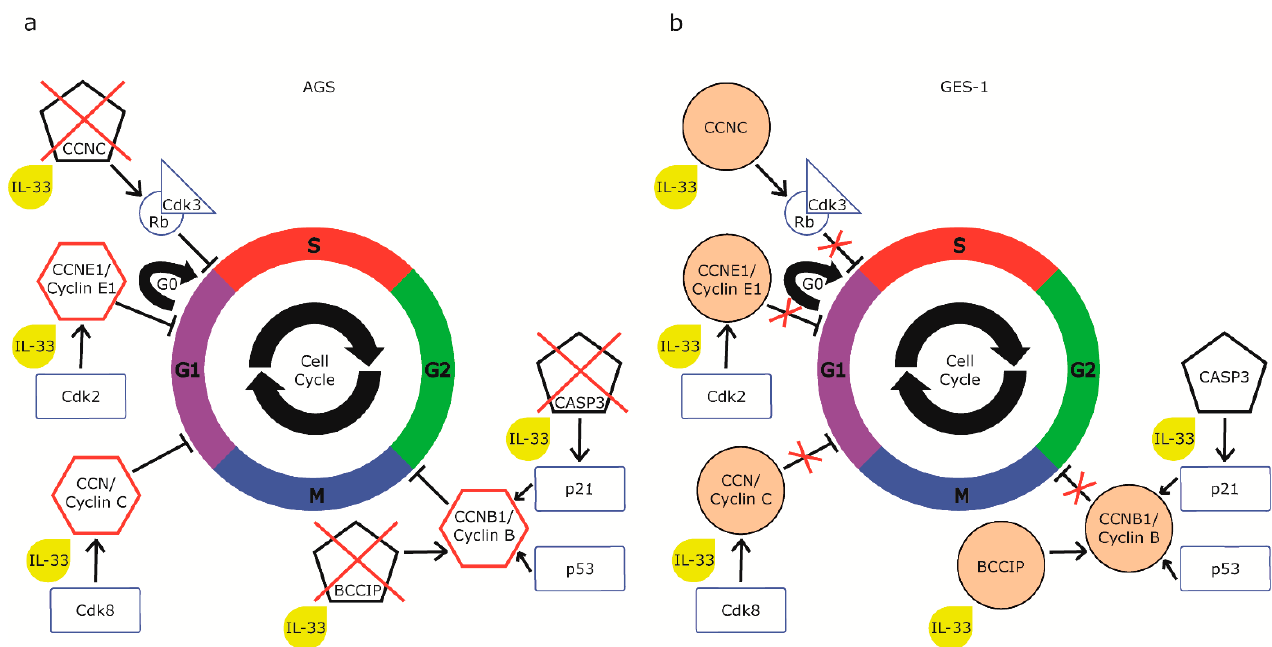
Figure 9. Schematic representation of cell cycle genes modulated by IL-33 shows that ( a ) in AGS, IL-33 interacts with genes that block G0/G1 transition as CCNC and G2/M transition as BCCIP and CASP3, leading to a reduction of cell proliferation, while ( b ) the induction of the overexpression of the same genes in GES-1 leads to an increase in proliferation.